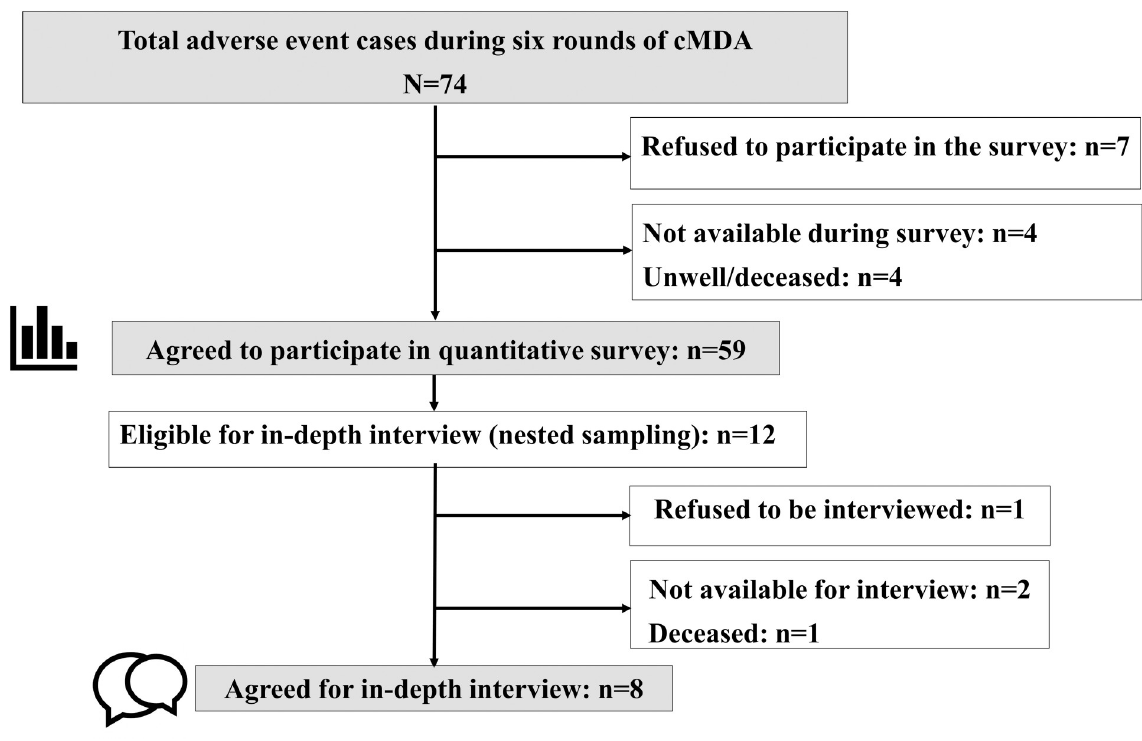
Fig 1. AE study participation